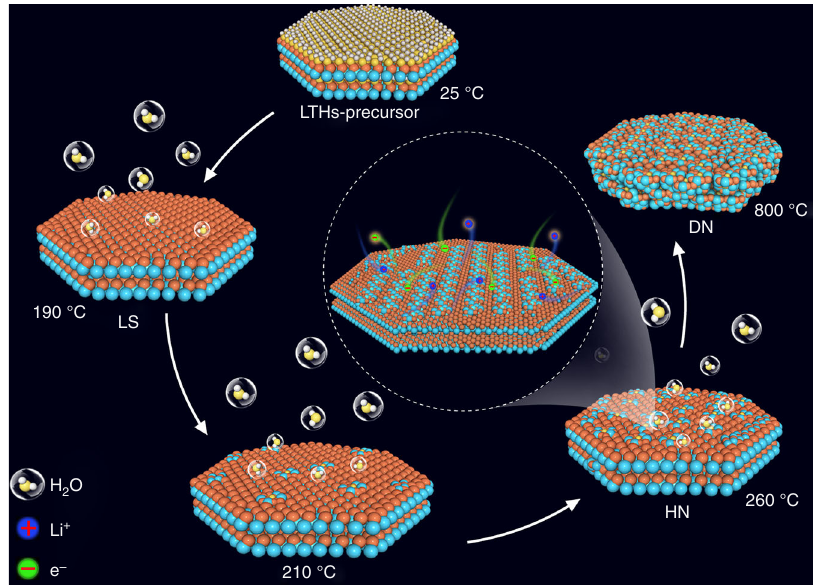
Fig. 2 Schematic diagram in the dehydration process and the fast lithium insertion/extraction within the hydrated nanocomposite (HN) material in battery. The tiny clusters appeared on the nanosheet after 190 °C represent LTO and TO nanocrystallites, and the clusters grow gradually to bigger crystals with the increase of